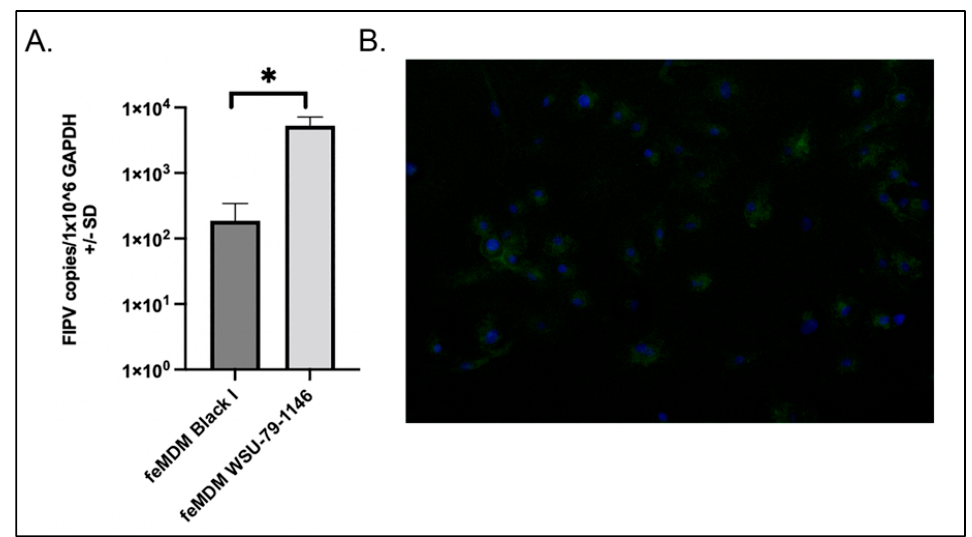
Figure 2. feMDM viral growth patterns and CD14 immunofluorescence. ( A ) Replication of serotype I and II FIPV in feMDM cells was quantified using RT-qPCR and was normalized to the expression of the housekeeping gene, GAPDH. Serotype II FIPV (WSU 79-1146) replicated more efficiently than serotype I FIPV (Black I) in feMDM cells (* indicates significance between groups, p = 0.0094, Student’s t -test). ( B ) Immunofluorescence of CD14 to confirm macrophage differentiation from feline monocytes (green fluorescence). Blue staining represents DAPI staining for cell nuclei. Green fluorescence (FITC) represents membranous CD14 staining.